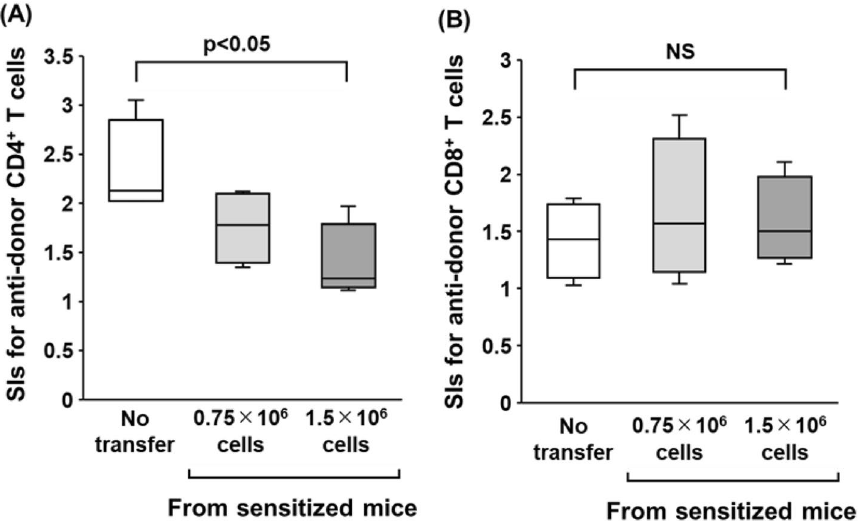
Figure 5. Evaluation of the dose effect of B cells from sensitized mice on anti-donor T-cell responses after B cell depletion with anti-CD20 mAb in a sensitized murine model. To investigate the inhibitory effects of B cells, various doses of B cells (0 × 10 6 , 0.75 × 10 6 , and 1.5 × 10 6 cells/well) from sensitized mice were co-cultured in CFSE-MLR assays of desensitized mice, and the dose effect of B cells on anti-donor T-cell responses were evaluated. The SI values of each of the anti-donor CD4 + T cell ( A ) and CD8 + T cell ( B ) subsets in MLR are shown. Data from five independent experiments are shown as median, 25th and 75th percentiles, and range. The Wilcoxon-Mann–Whitney test was used to evaluate differences between the doses of B